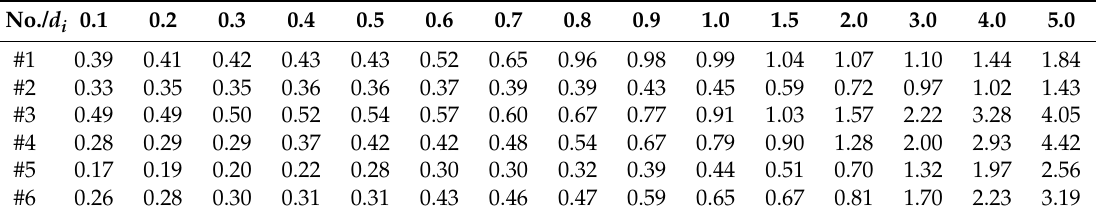
Table 1. Impact of contour interval d i on the accuracy of building model reconstruction.